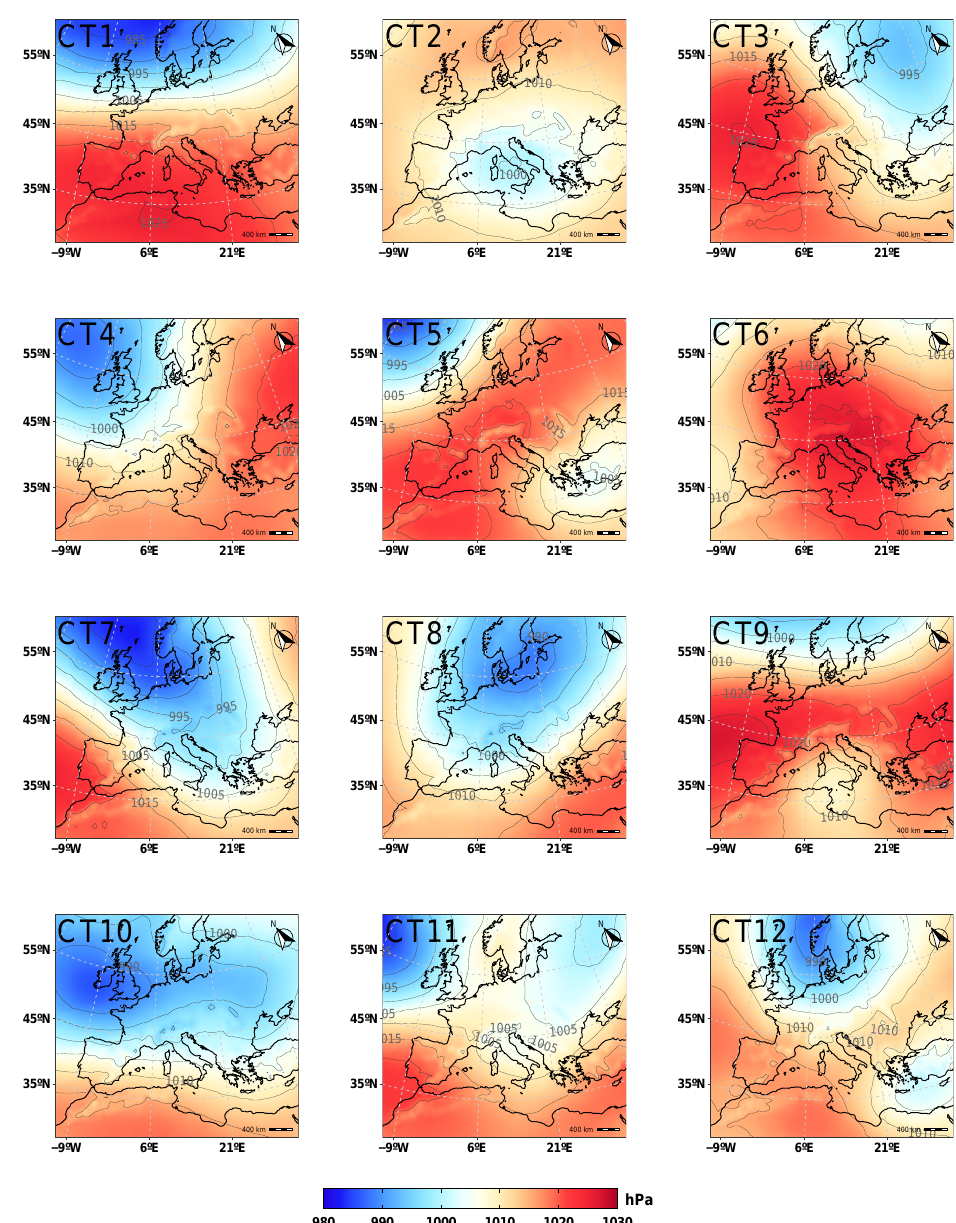
Figure 1. Circulation Types (CTs) over Europe for wintertime (DJF) in the BASE experiment, ordered by their frequency. These 12 CTs explain 90.58% of the total